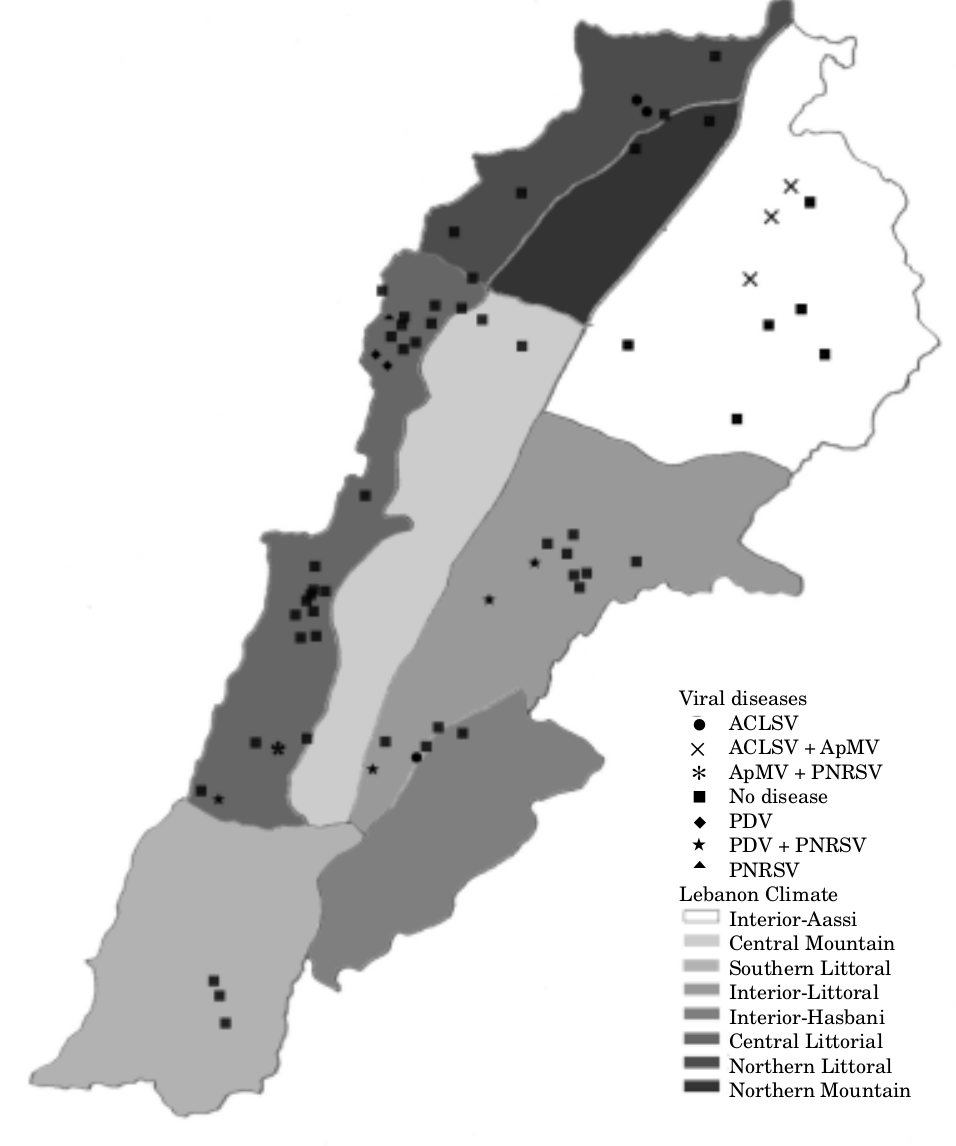
Fig. 1. Occurrence and distribution of viral diseases of almond in Lebanon. The different climatic regions are